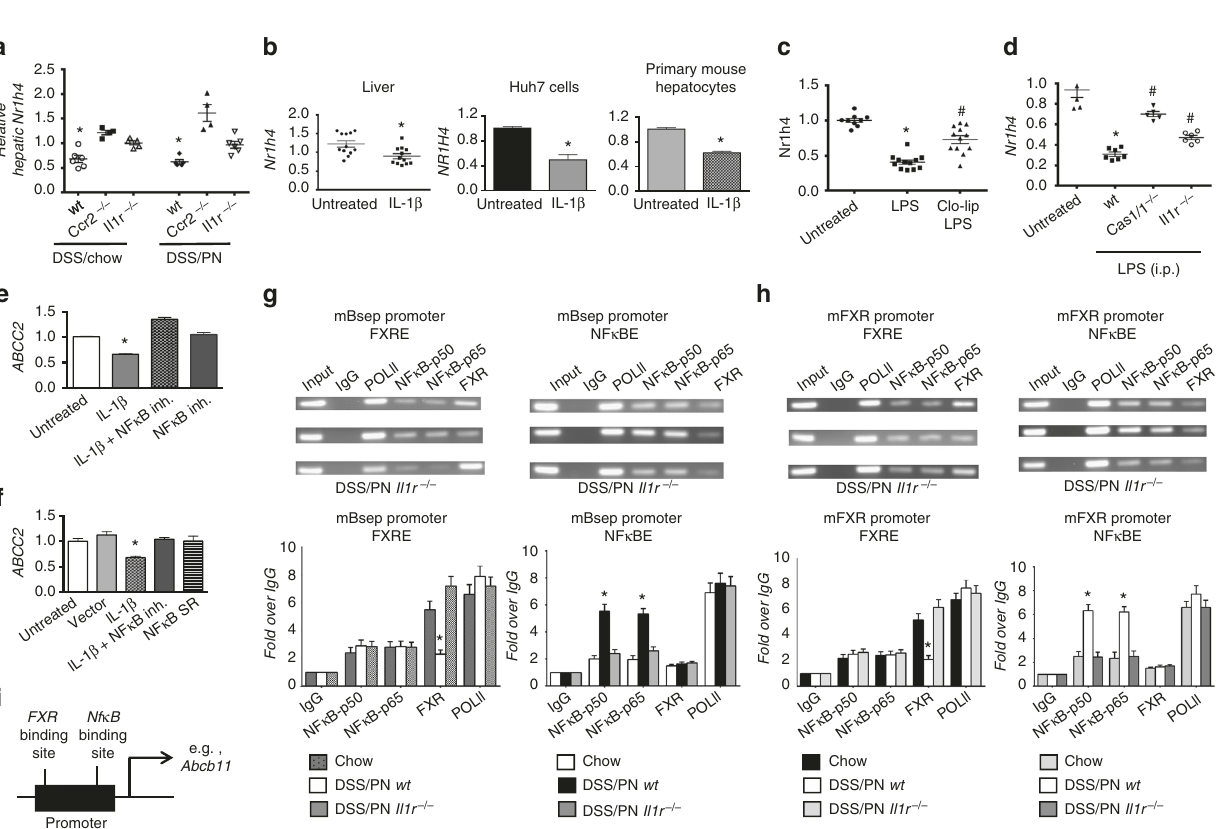
induced in Il1r − / − Ccr2 − / − , and anakinra-treated DSS/PN mice (Fig. 5a). Similar fi ndings were observed for expression of Nr1h3 , the gene encoding the transcription factor LXR that induces expression of Abcg5/8 48 (Fig. 5a). To determine the role of IL-1 β and LPS in this transcriptional suppression, i.p. injection of 200 ng/mouse IL-1 β or of 2.5 mg/kg LPS was given to otherwise untreated WT mice and resulted in signi fi cant transcriptional suppression of Abcg5/8 mRNA in livers of both groups (Fig. 5b).